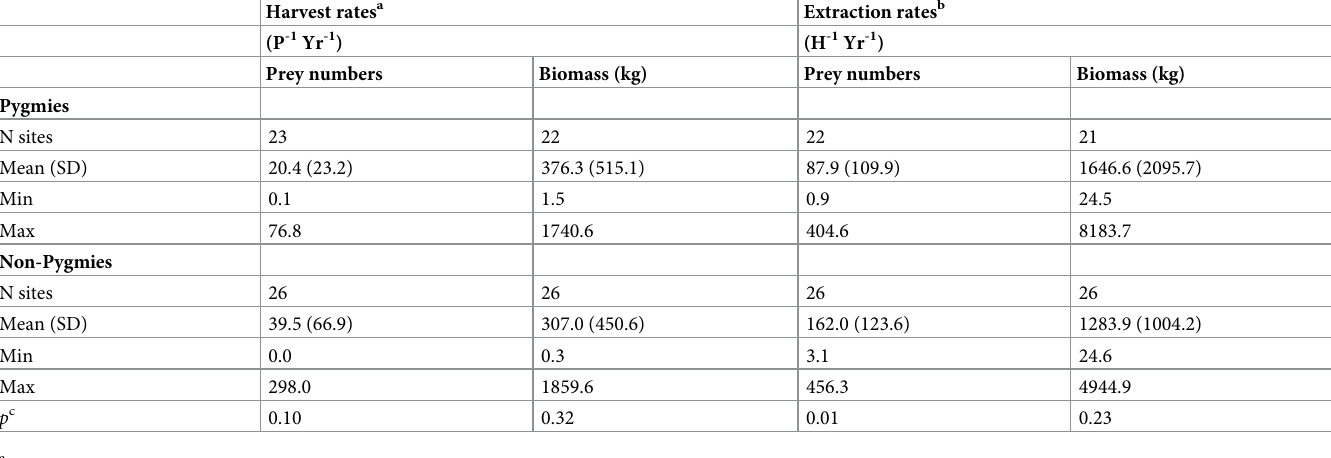
Table 1. Per capita harvest and extraction rates for Pygmy and non-Pygmy settlements. Harvest rates a